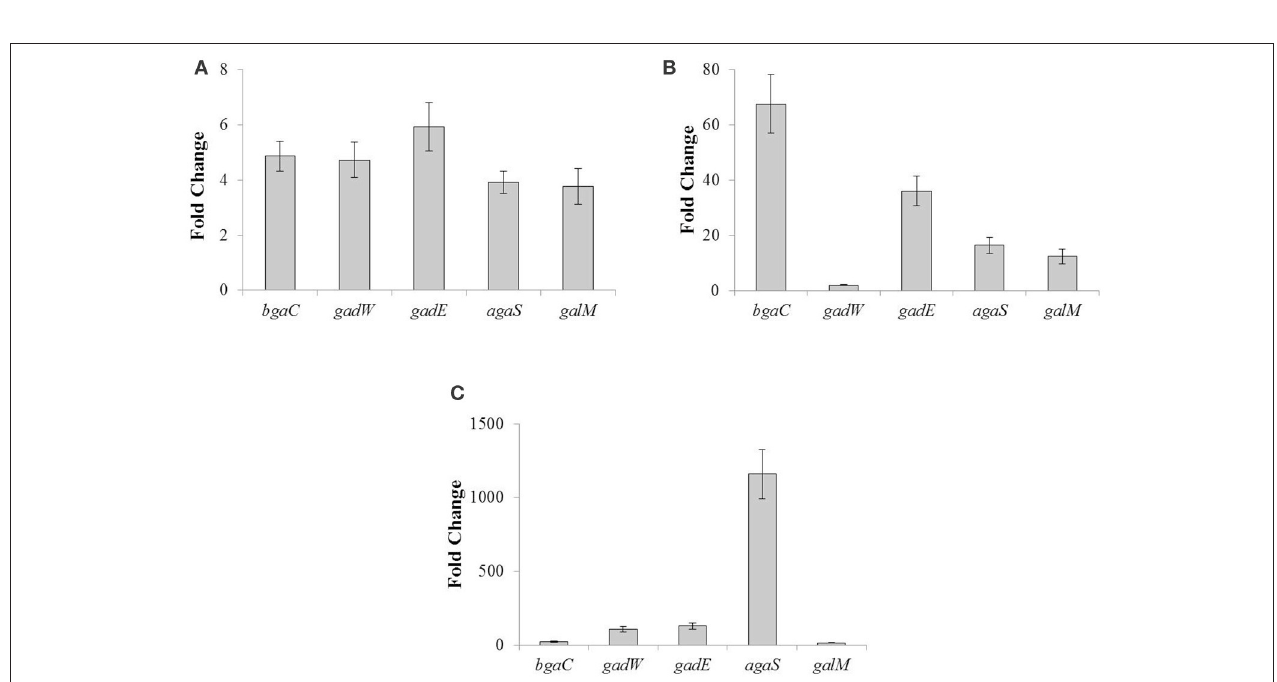
FIGURE 2 | The relative increase in the expression of the genes belonging to the aga operon. (A) S. pneumoniae D39 wild-type was grown in GM17 (0.5% Glucose + M17) and NAGaM17 (0.5% NAGa + M17). Ratio represents an increase in the expression of the aga operon genes in S. pneumoniae D39 wild-type